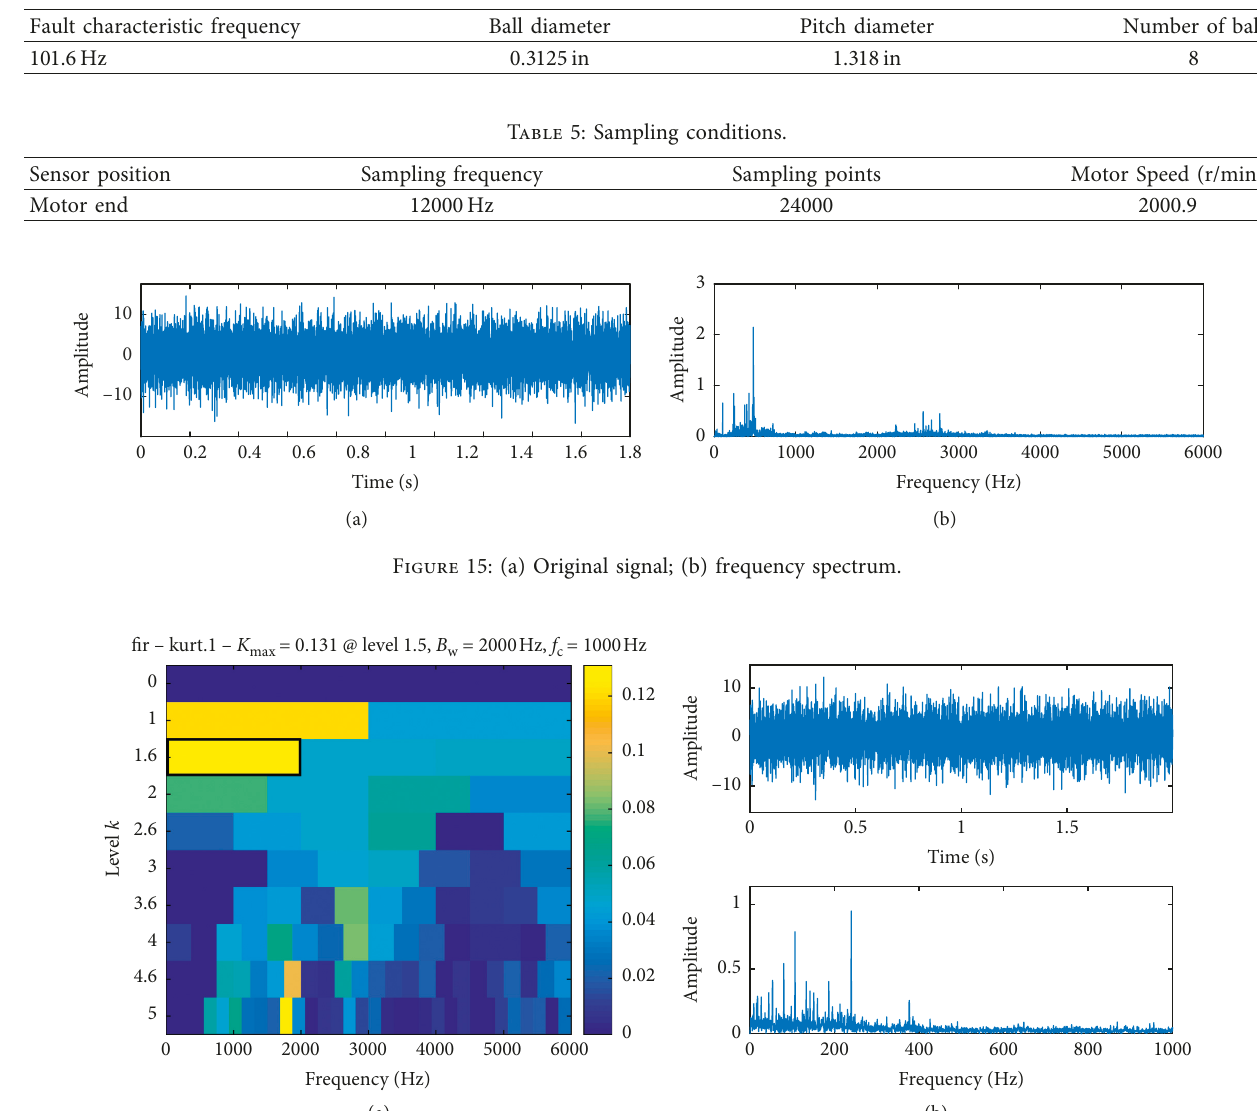
Table 4: Parameters of the outer ring fault bearing.